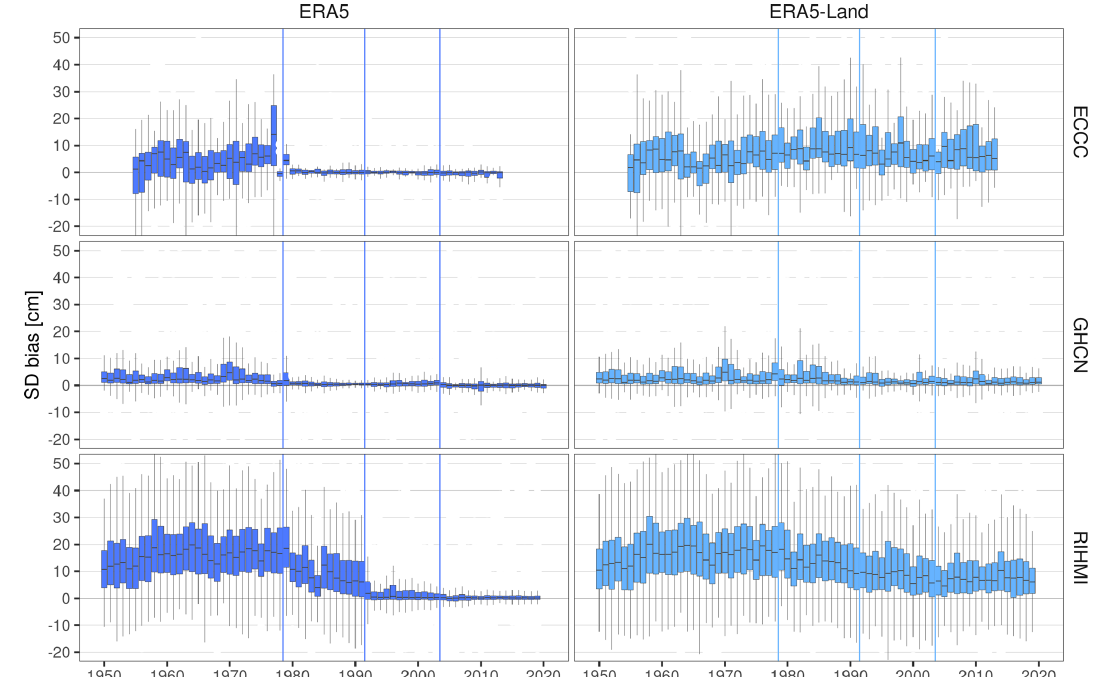
Figure A4. Temporal stability of the bias (product – station) in snow depth (SD) per product and network during DJF. Vertical lines show the years when the potential discontinuities in each product occur.